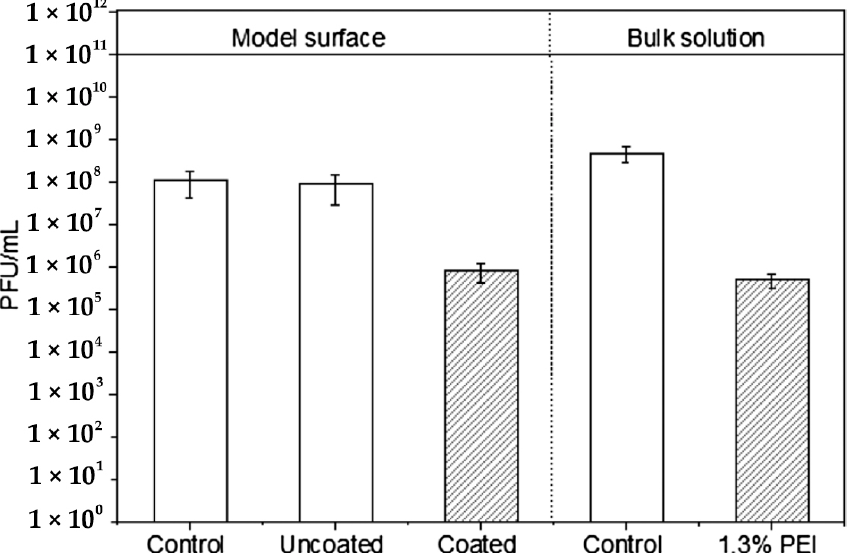
Figure 5. PEI MS2 reduction in model surface (glass-sliders) and in the bulk solution. Reprinted from